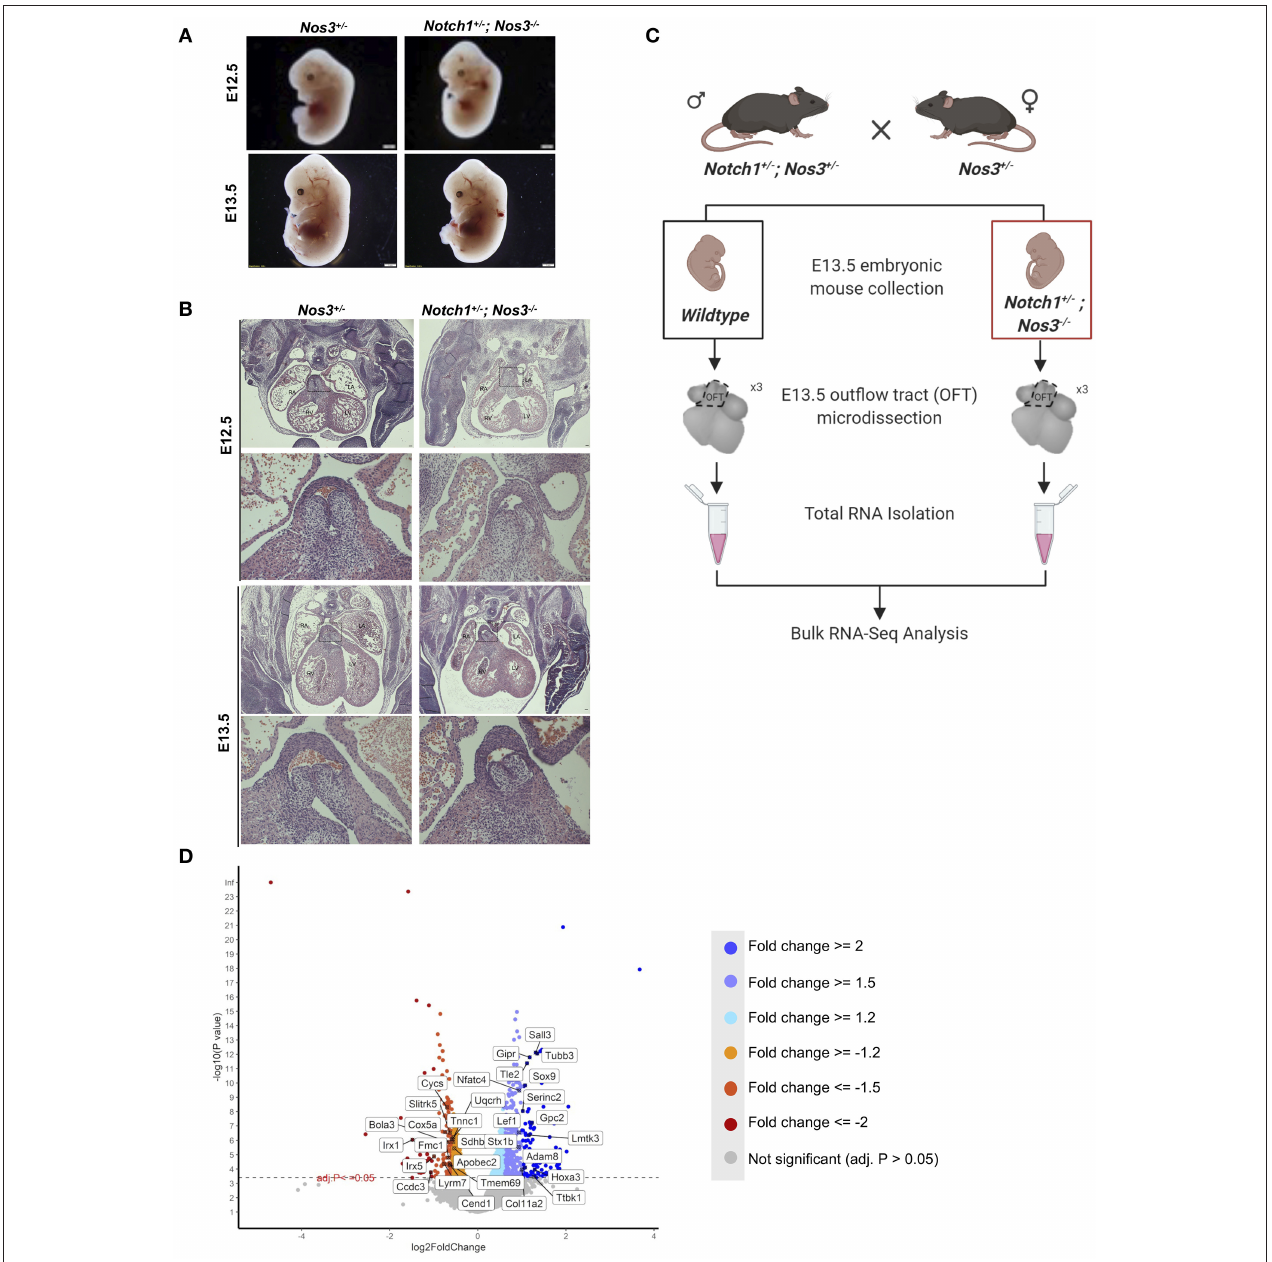
FIGURE 2 | Histologic and RNA-Seq analysis of Notch1 + / − ; Nos3 − / − embryos. (A) Notch1 + / − ; Nos3 − / − compound mutant embryos do not show any size differences at E12.5 or E13.5 ( n = 3). (B) Histological section (stained with hematoxylin and eosin) of E12.5 and E13.5 Notch1 + / − ; Nos3 − / − embryonic hearts demonstrates no gross morphological differences. Outflow tract (boxed area in low magnification image) is shown in higher magnification (below) and no differences are noted when compared to Nos3 + / − littermate controls ( n = 3). (C) Schematic diagram outlining process of OFT collection and bulk RNA-Sequencing from E13.5 Notch1 + / − ; Nos3 − / − and wildtype embryos. (D) Volcano plot of 1,352 differentially expressed genes sorted according to fold change and significance (adjusted p -value < = 0.05). Significantly downregulated genes with a fold change < − 2, < − 1.5, < − 1.2 are labeled in orange, coral, and red, respectively. Significantly upregulated genes with a fold change > 2, > 1.5, > 1.2 are labeled in turquoise, light purple, and blue, respectively. Highlighted genes are top 15 upregulated and downregulated genes that also have a Notch1 ChIP peak according the previously published Notch1/Rbpjk in mouse ChIP-Sequencing dataset (51). Figure 2C was generated on www.Biorender.com.